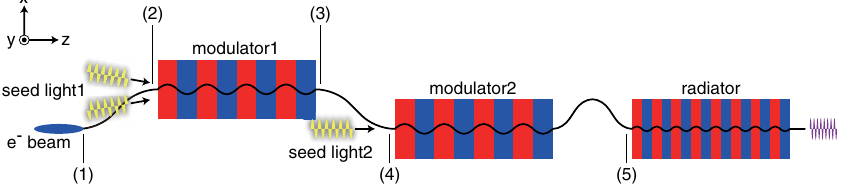
FIG. 1. Layout of the proposed scheme; the numbers from (1) to (5) show the longitudinal positions where the electron distributions are shown later in Fig. 2 or in Fig. 5.